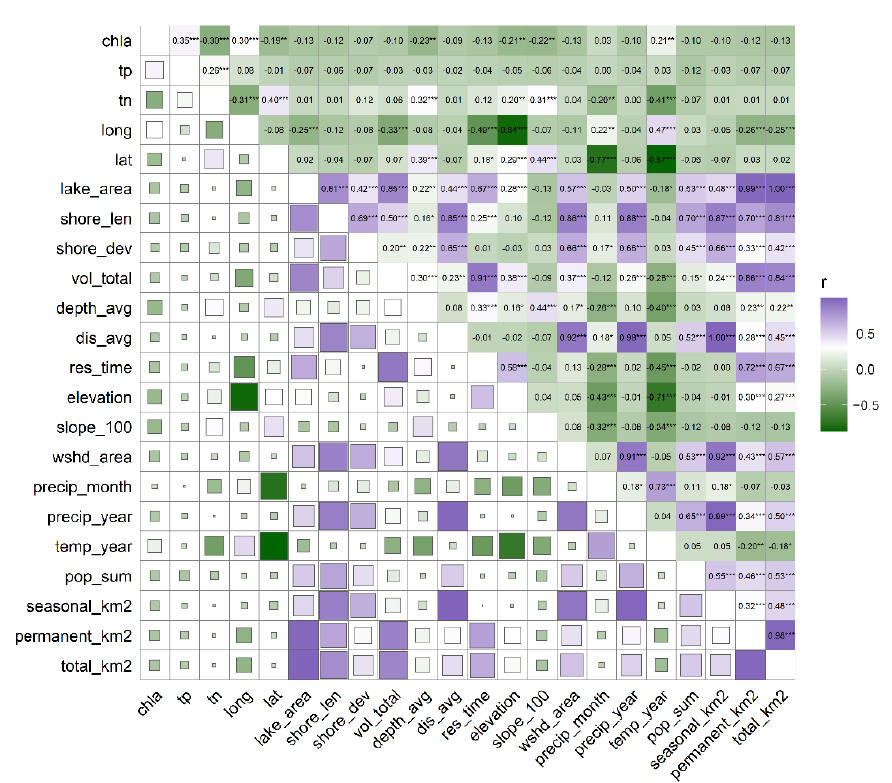
Figure 3. Visual graph of the correlation coefficient between parameters. The upper right is the cal- culated correlation between the two parameters, r > 0 represents the positive correlation, and r < 0 represents the negative correlation, indicating the degree of significance; * p < 0.05; ** p < 0.01; *** p < 0.001); the lower left is a square drawn according to the correlation degree value. Purple represents a positive correlation between variables, and green represents a negative correlation between vari- ables. The deeper the color, the stronger the visibility between the two factors.